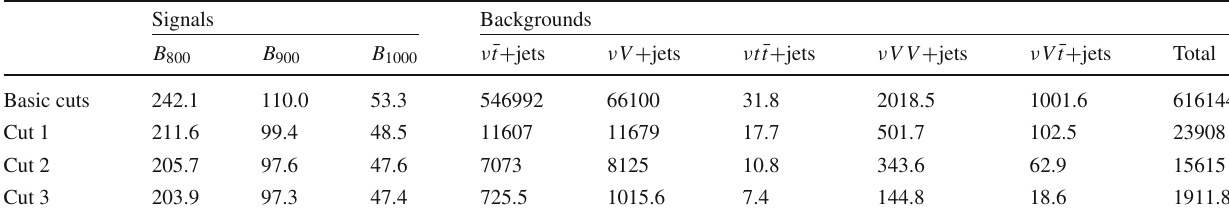
, (cid:12) R , M and H for signals and backgrounds at the LHeC ( T j 1 , j 2 j 1 , j 2 T √ s = 1 . 98 TeV) with the integrated luminosity L = 1000 fb − 1 . Here, we take = 0 . 1 and R = 0 . B L